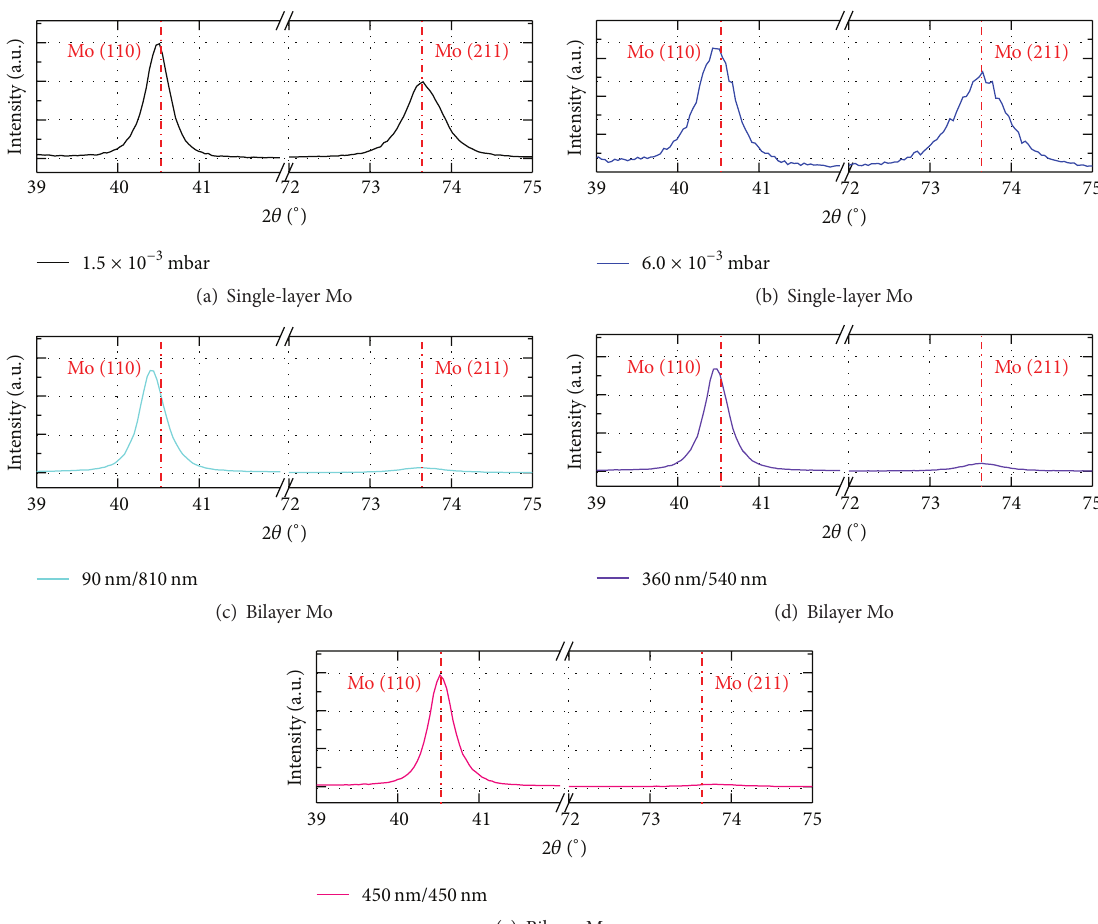
Figure 3: XRD patterns of single-layer and bilayer Mo films. The scanning range is centered at the Mo (110) and Mo (211) lattice planes.